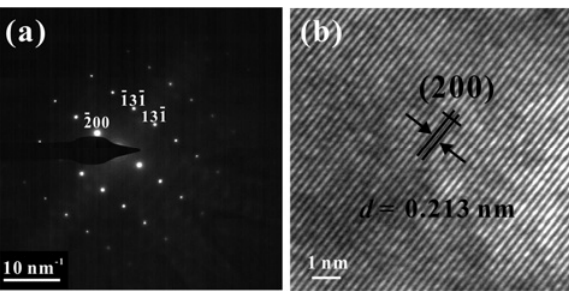
Fig. 5 (a) SAED pattern with the beam direction parallel to [013] zone axis; (b) HRTEM micrograph showing (200) plane spacing.